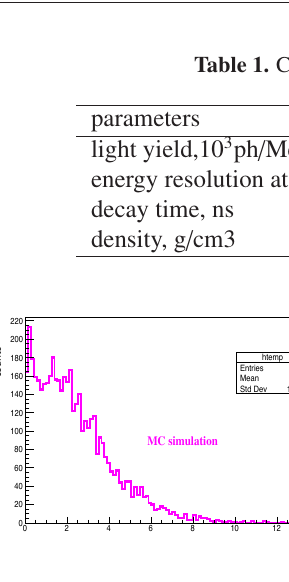
Figure 3. Energy release: Monte Carlo simulation and experimental data for 51 MeV-photon irradiation of SpaCal. The di ff erent colours of line correspond to a few small falling angles of a photon beam (the right